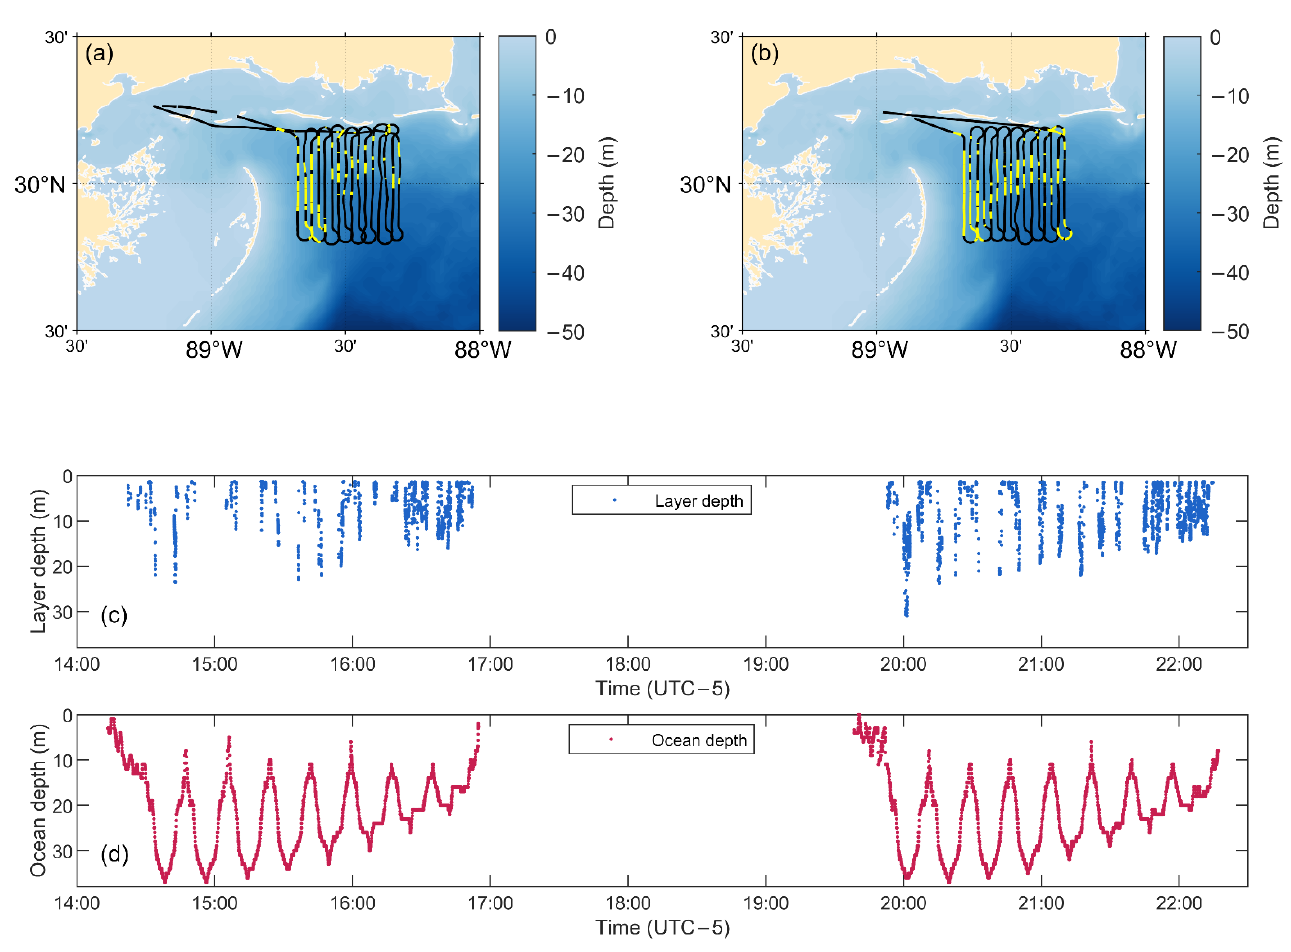
Figure 12. The maps of layer distribution and layer depth variation with time in the two detections on 4 October. ( a ) Layer distribution of the first detection. The black line is the flight route. The yellow lines are the positions where thin layers were detected; ( b ) Layer distribution of the second detection. The black line is the flight route. The yellow lines are the positions where thin layers were detected; ( c ) Layer depth variation during both detections; ( d ) Ocean depth variation during both detections.